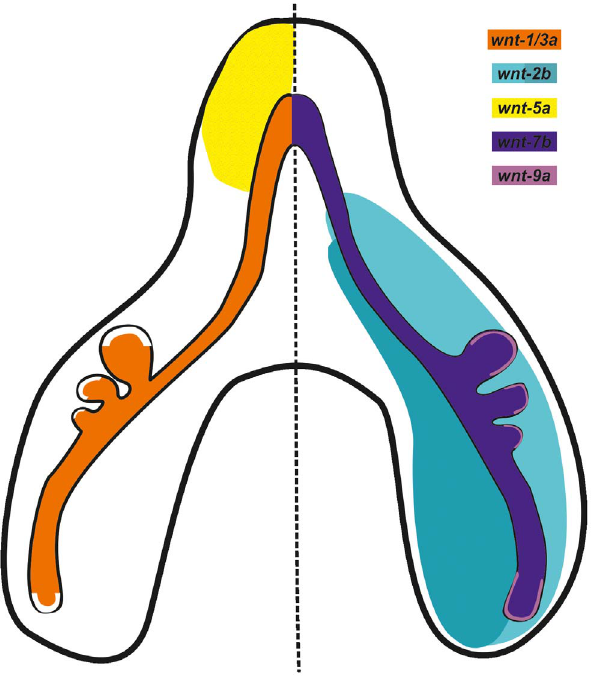
Figure 2. Schematic diagram of Wnt ligands expression pattern in a b3 stage lung. For simplicity, image was divided in half in order to avoid color overlay. Orange: wnt-1 and wnt-3a expression; turquoise: wnt-2b expression; yellow: wnt-5 a expression; dark blue: wnt-7b expression; purple: wnt-9a expression. Dual colors highlight different levels of expression.